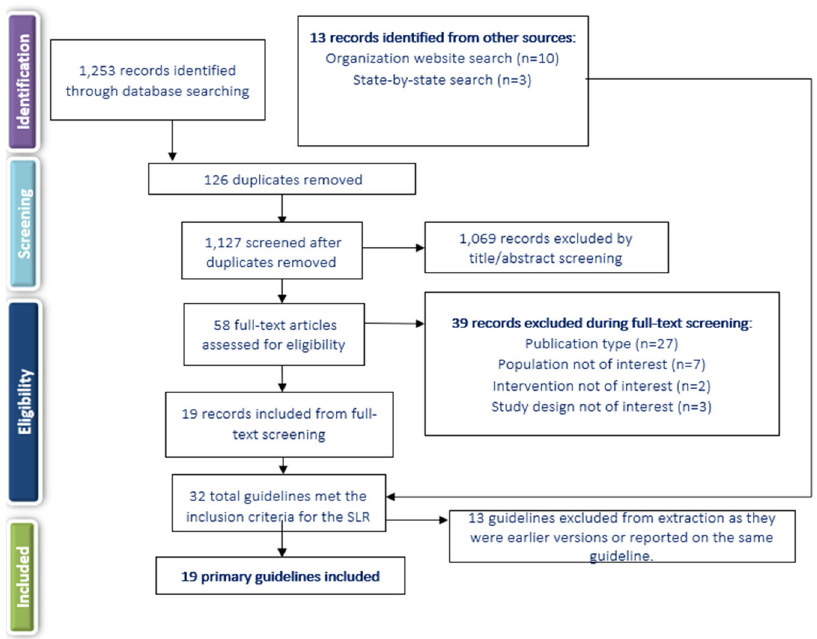
Fig. 1 PRISMA diagram. SLR systematic literature